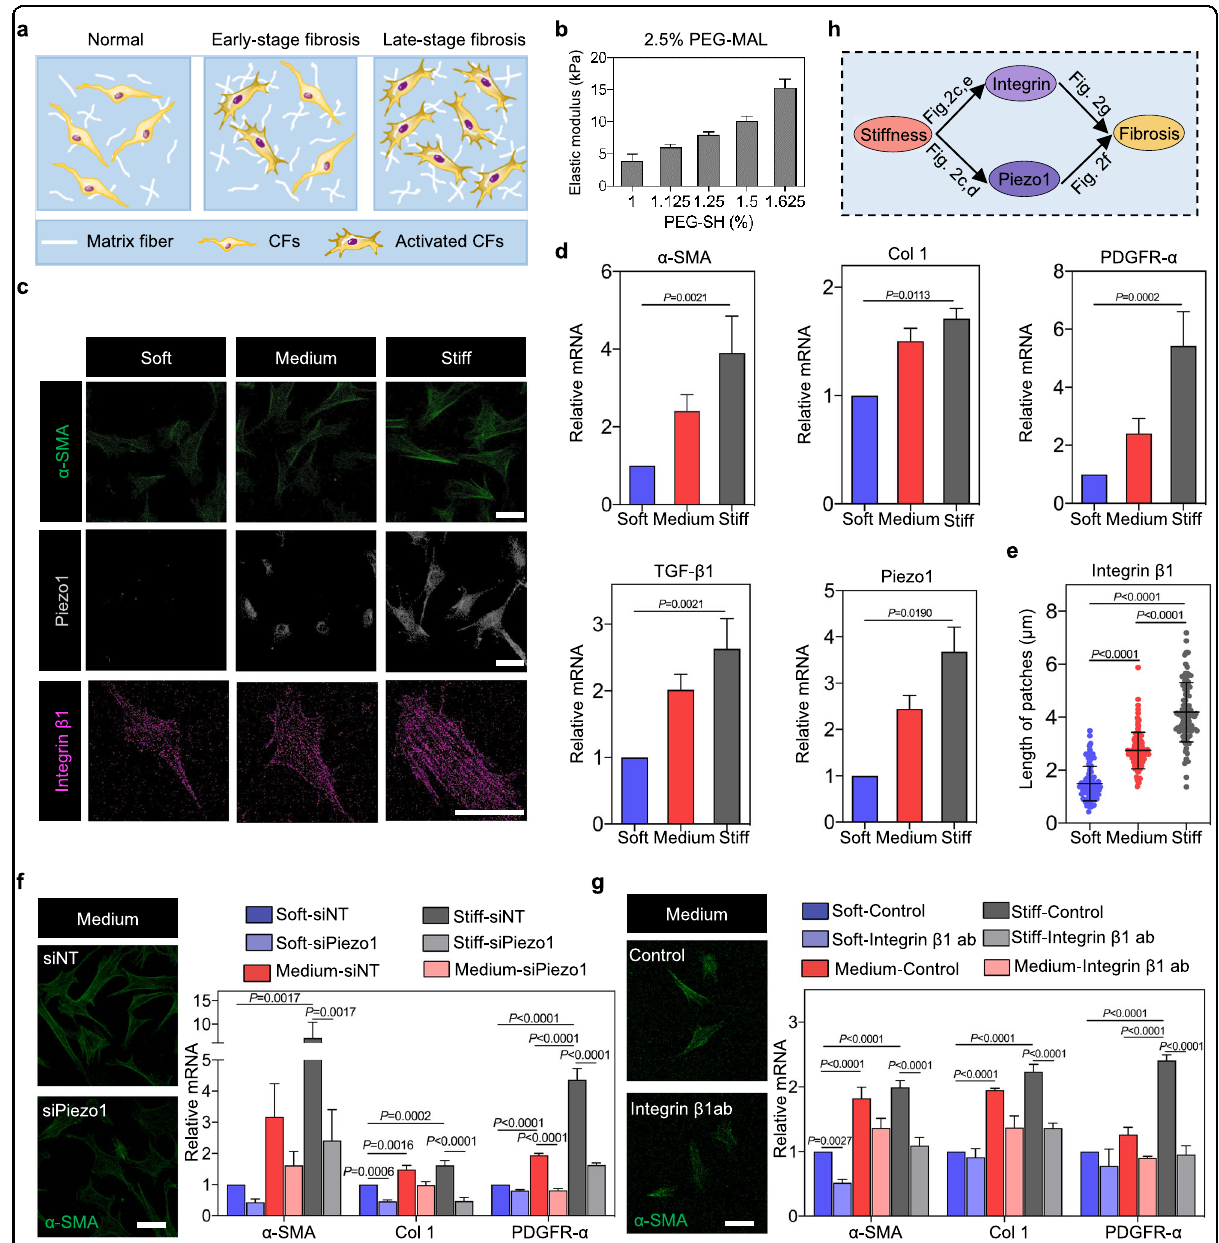
Fig. 2 Matrix stiffness-mediated increases of Piezo1 and integrin β 1 promote CF activation in vitro. a Schematic of different stages of cardiac fi brosis. In injured regions, accumulation of ECM proteins promotes tissue stiffening. b Moduli of peptide-modi fi ed PEG-MAL hydrogels with increasing concentration of PEG-SH. PEG-SH was swollen into the network (2.5% of PEG-MAL) at 1%, 1.125%, 1.25%, 1.5%, and 1.625%, resulting in hydrogels with stiffness of 4, 6, 8, 9, and 15 kPa, respectively. Elastic modulus was measured by rotational rheometry. c Immuno fl uorescence analysis indicated enhanced activation of CFs with increasing matrix stiffness (gray, Piezo1; green, α -SMA; Pink, Integrin β 1). Scale bar, 50 μ m. d RT-PCR analysis of α -SMA, PDGFR- α , TGF- β 1 and Col 1 in CFs after 7-day culture. e Quanti fi cations of integrin β 1 plaque size on matrices of different elastic modulus ( n ≥ 90 data points). f Immuno fl uorescence and RT-PCR analyses of α -SMA, Col 1 and PDGFR- α indicated that activation of CFs decreased following siRNA silencing of Piezo1 (green, α -SMA). Scale bar, 50 μ m. g Immuno fl uorescence and RT-PCR analyses of α -SMA, Col 1 and PDGFR- α indicated that activation of CFs decreased in integrin β 1-depleted CFs, both with and without integrin-blocking antibodies (green, α -SMA). Scale bar, 50 μ